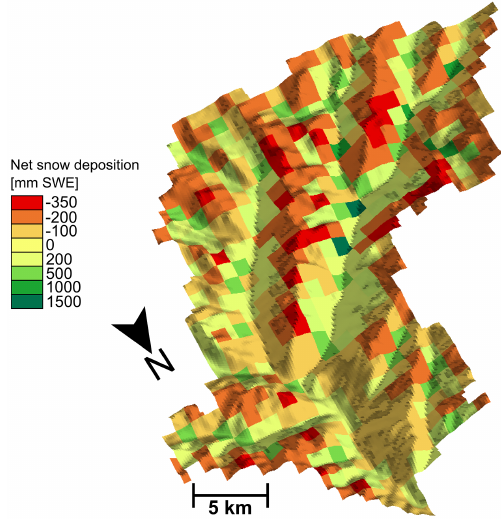
Figure 11. Net snow deposition in the catchment during the time period of 1 year. Negative values refer to a net loss and positive values to a net gain of snow. Note that, since only the net deposition of snow based on lateral transport is shown, values cannot be linked to snow depths at the end of the time